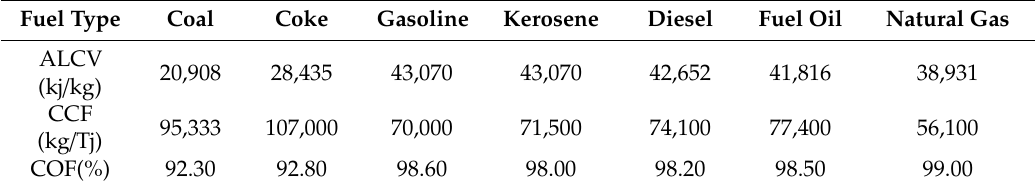
Table 1. The carbon emission factors of various types of fossil